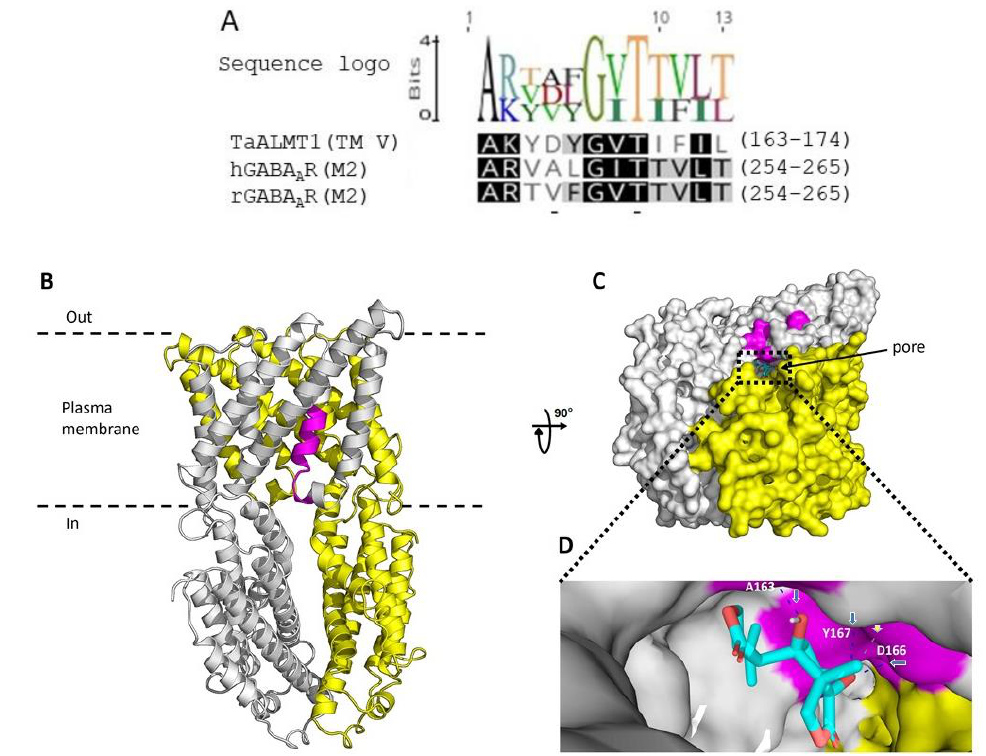
Figure 6. Possible binding site/s for picrotoxin in TaALMT1. ( A ) The GABA A pore lining, TM2, of the α subunit of the mammalian GABA A receptors has residues (valine and threonine) that are linked to picrotoxin binding. The TaALMT1 motif in TM5 has the residues aspartate and threonine (underlined) located in the same positions, and these residues may be involved in picrotoxin binding. The logo depicts the residue frequencies at each position within the motif in TaALMT1 and in mammalian GABA receptors. Identical residues are shaded in black; 80% similar residues are shaded in grey, and residues with similarity < 60% are unshaded. Full-sequence identifiers are TaALMT1 (DQ072260), the human GABA receptor alpha subunit (P14867), and the rat GABA receptor alpha subunit (P62813). ( B ) Homology model of TaALMT1 shown as ribbon representation viewed from the side of the plasma membrane. The TaALMT1 homodimer displays subunits A (grey) and B (yellow). The motif in TM5 is highlighted in magenta. ( C ) Picrotoxin docking to TaALMT1. Picrotoxin (cyan) docked into the pore of TaALMT1 and shown in a representative orientation (rotated 90° from B and viewed from the intracellular side). The dashed lines show the